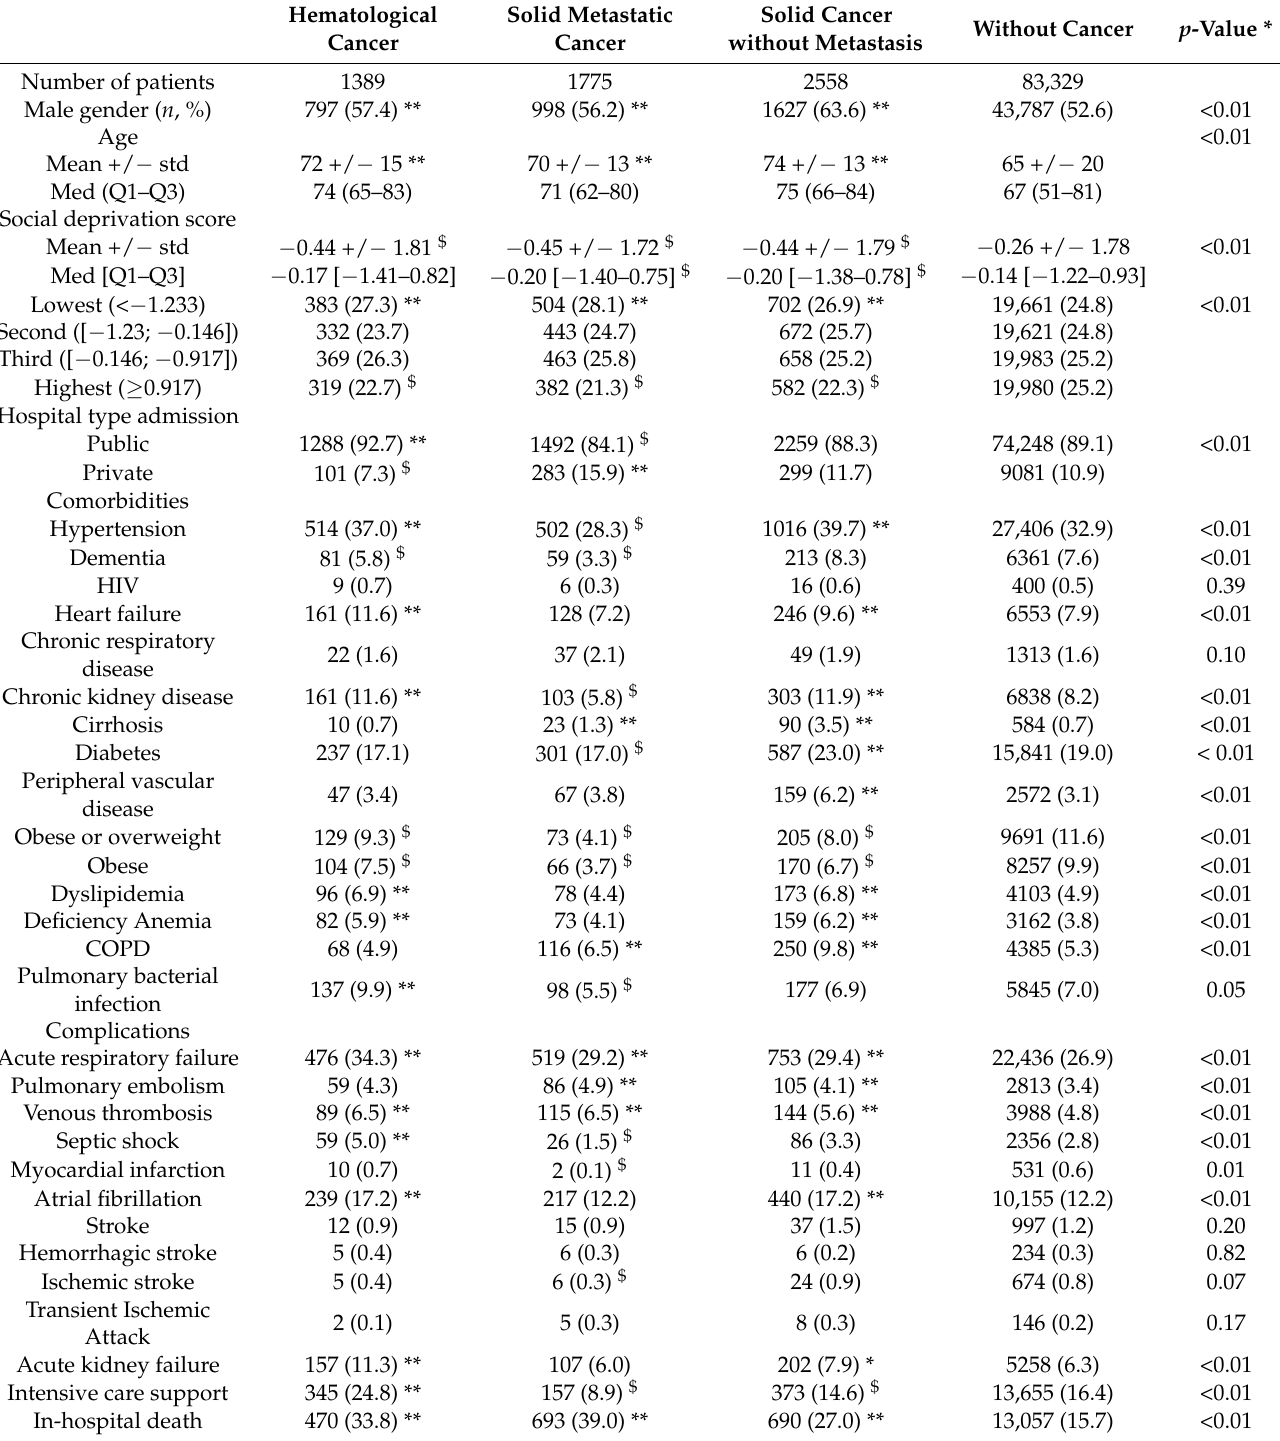
Table 2. Main baseline characteristics of patients hospitalized in France for COVID-19 (from 1 March 2020 to 30 April 2020) according to the presence of cancer and cancer